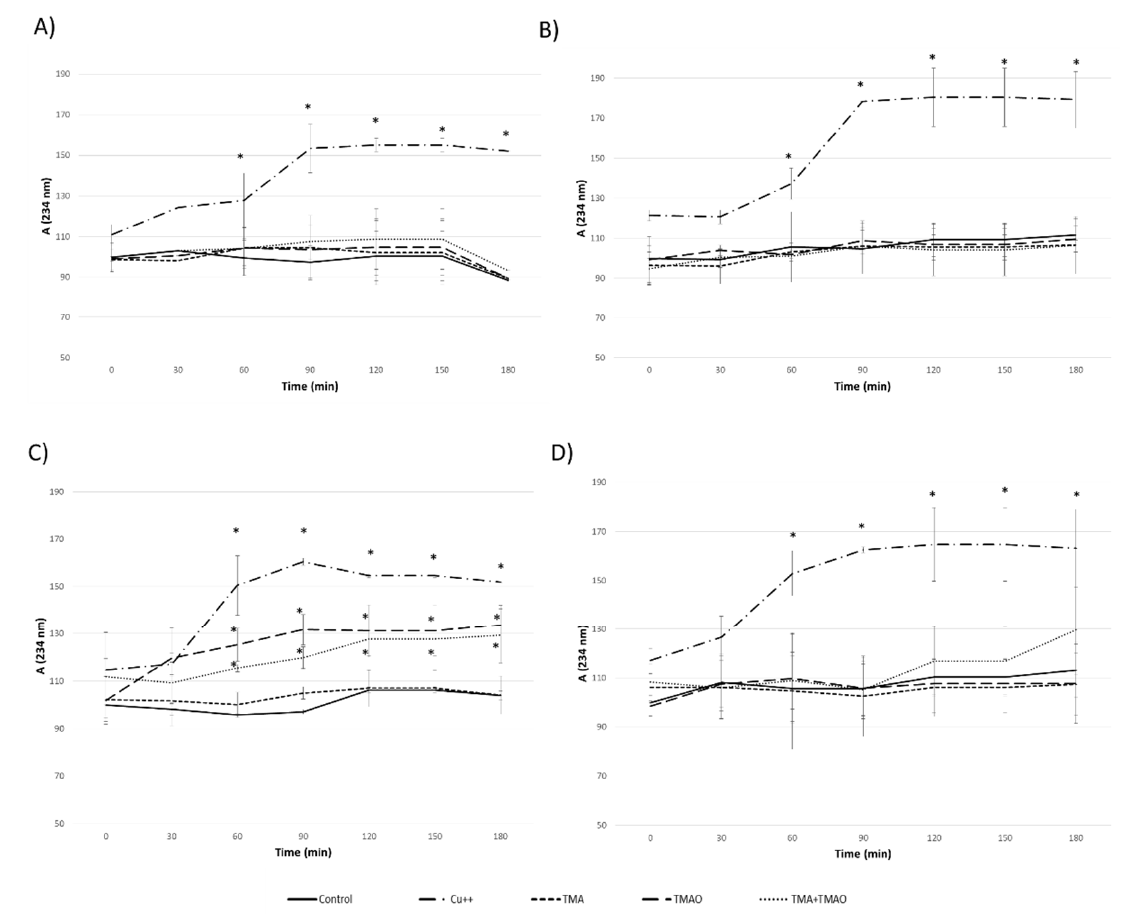
Figure 4. LDL oxidation was measured by a change in absorbance (mean value ± SD) at 234 nm of LDL (0.01 mg/mL) incubated with 5 µM Cu ++ with ( A ) 0.6 µM TMA, 5.37 µM TMAO; ( B ) 0.82 mM TMA, 9.54 mM TMAO; ( C ) 2.46 mM TMA, 28.6 mM TMAO; ( D ) 24.6 mM TMA, 2.86 mM TMAO; * p < 0.05.